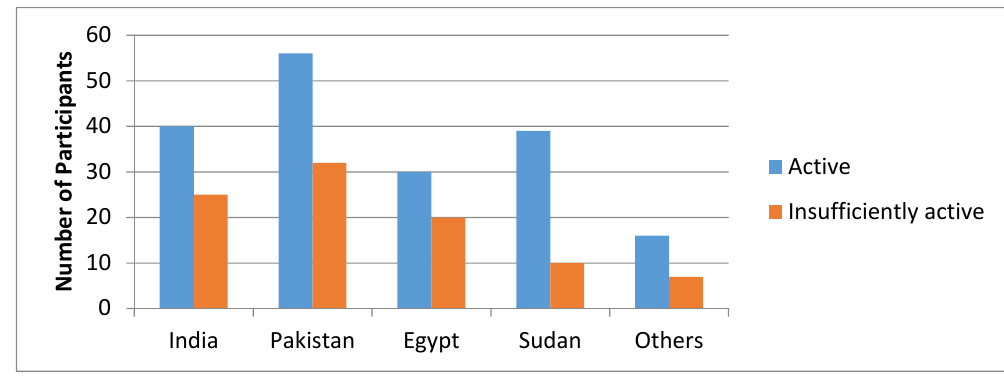
Figure 2. Level of physical activity categorized using Godin-Shephard Leisure-Time Exercise Questionnaire (GSLTPAQ).